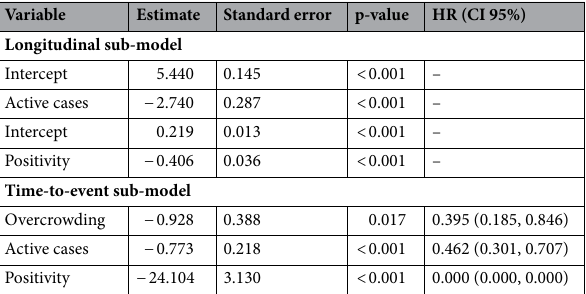
Table 2. Bivariate joint model. Coefficient estimates, standard errors, and p-values for explanatory variables in both longitudinal and time-to-event sub-model, and hazard ratio (HR) estimates with their corresponding 95% confidence intervals